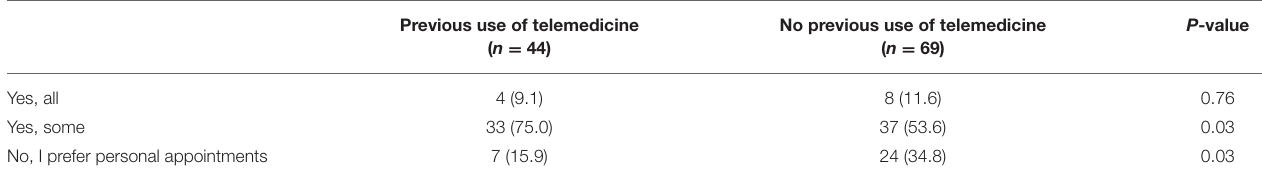
TABLE 2 | Consideration of future telemedicine